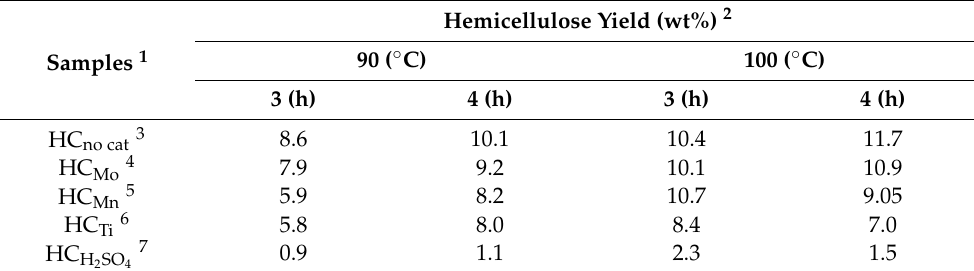
Table 1. Hemicellulose yields from the soluble products of oxidative delignification of spruce wood with and without catalysts at process temperatures of 90 ◦ C and 100 ◦ C and process times of 3 and 4